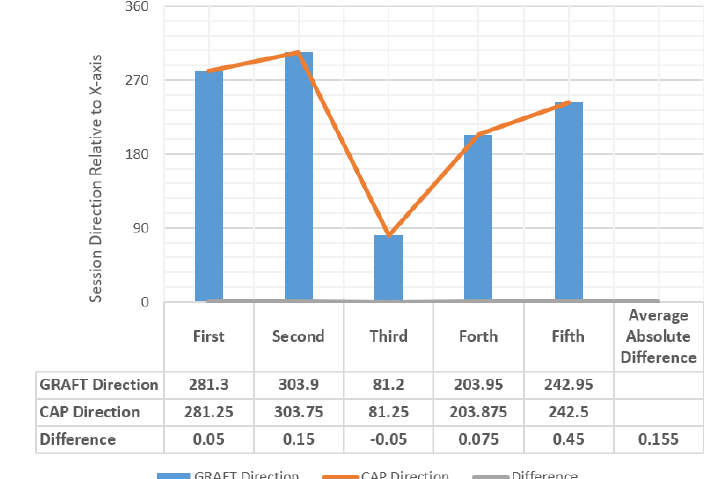
Figure 8. Comparison results of GRAFT and CAP.